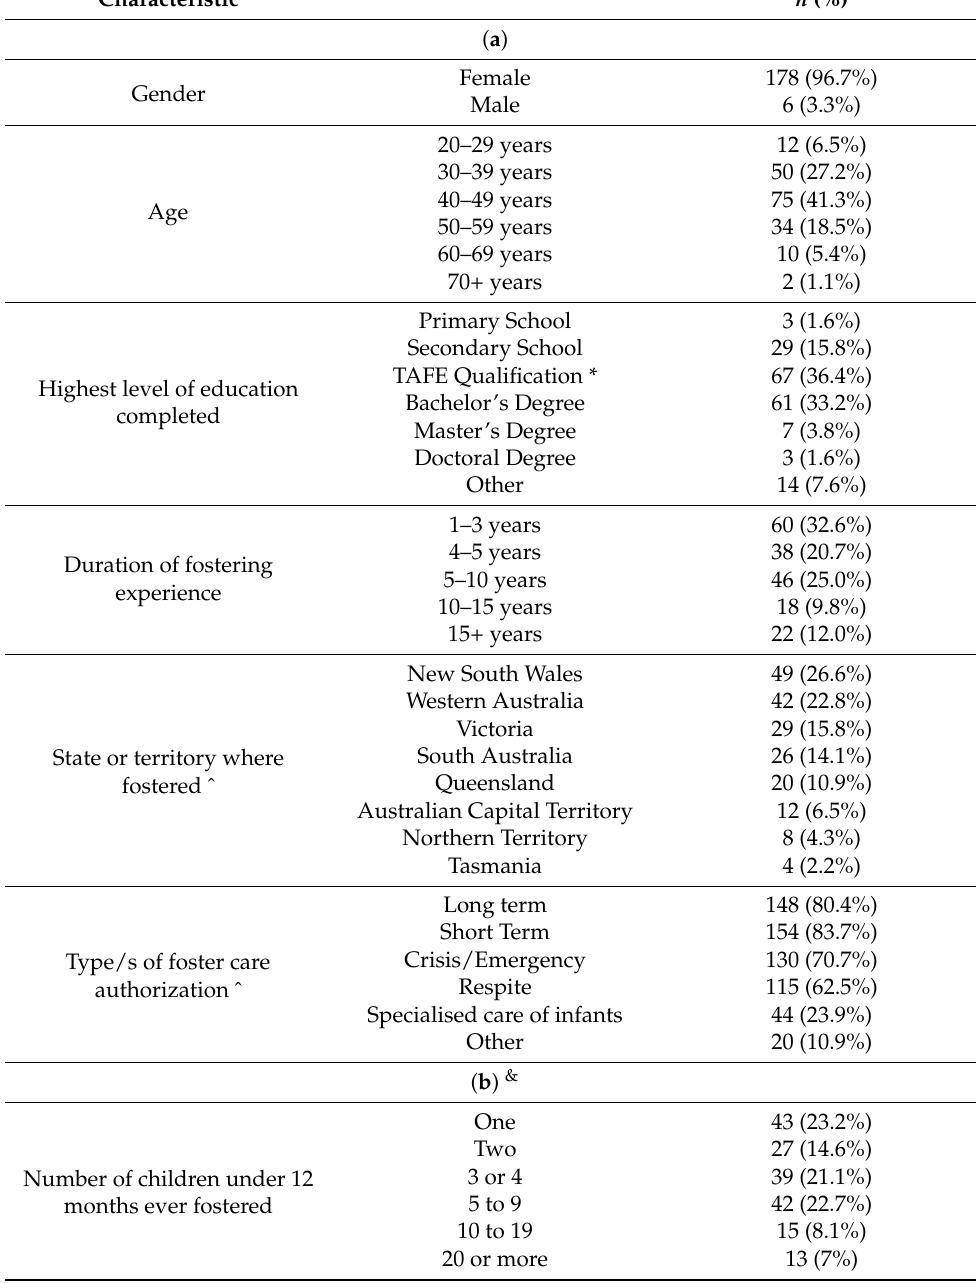
Table 1. ( a ): Demographic characteristics. ( b ): Number of infants ever fostered by study